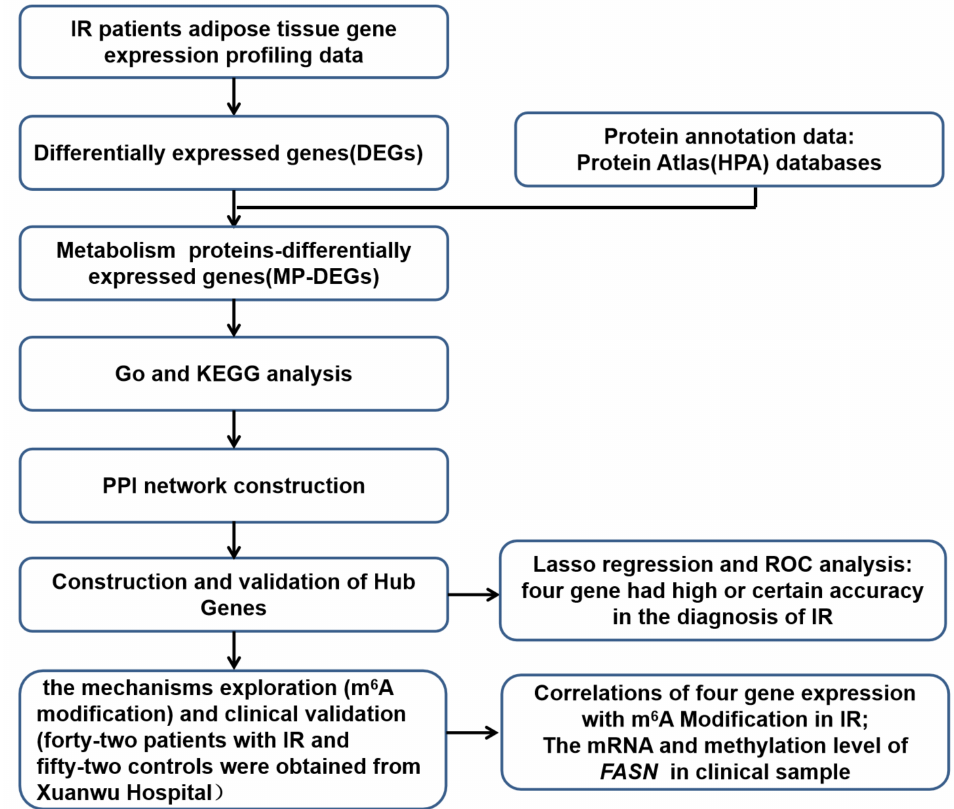
Figure 1. Flowchart of the study